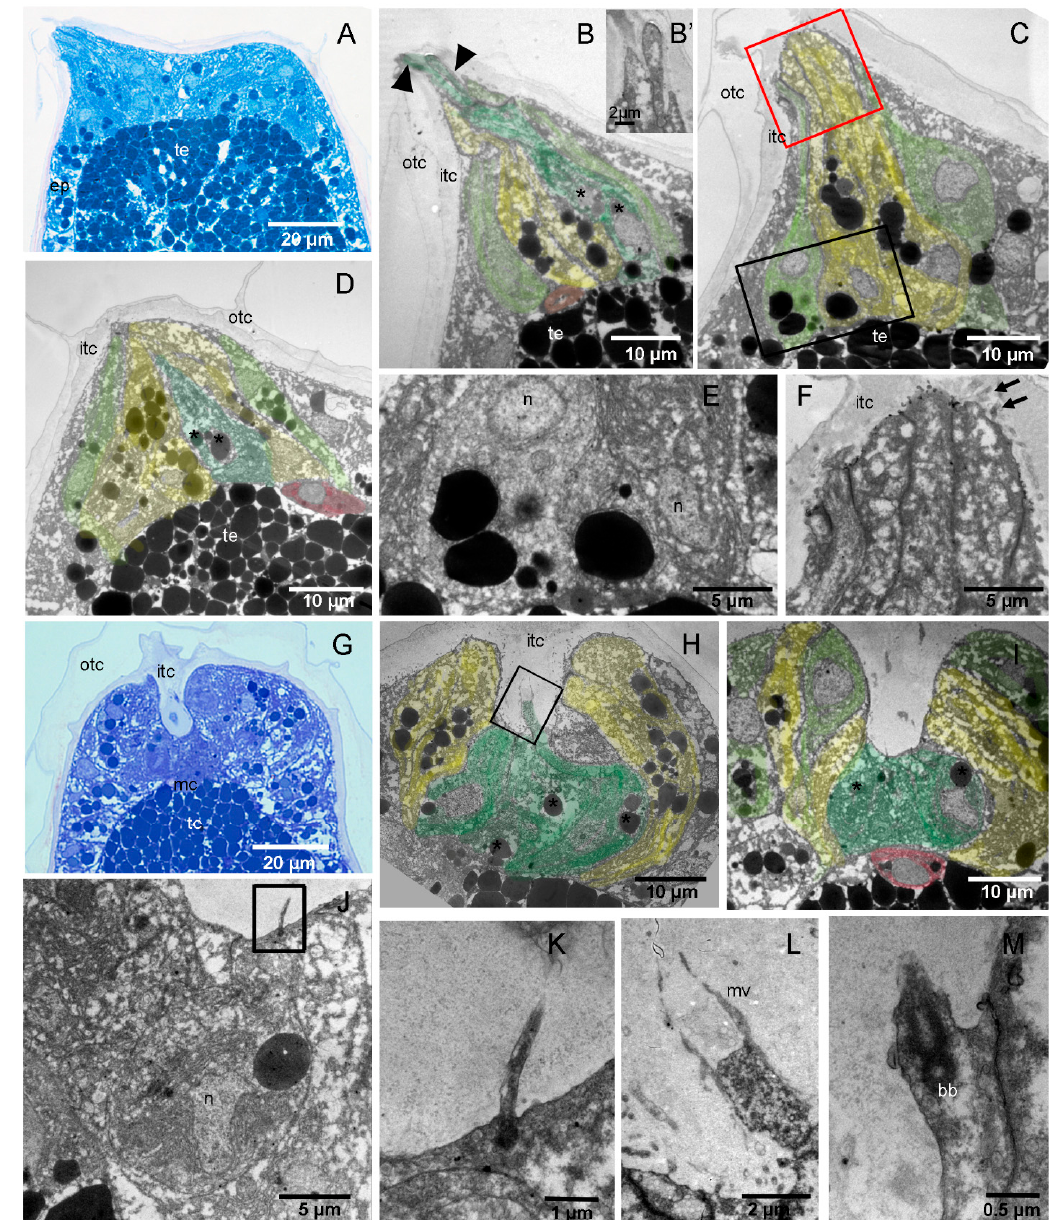
Figure 4. Histological and ultrastructural analysis of adhesive papillae in H. roretzi . ( A – F ) Swim- ming larva: the papillae are conic. ( G – M ) Adhering larva: the papillae have a central groove. ( A , G ) Longitudinal sections of the anterior trunk. Toluidine blue. ( B – F , H – M ) TEM images at differ- ent magnifications and different levels of papillae. Colour code: dark green, ACCs; light green, PSNs; red, mesenchyme cells; yellow, CCs. ( B – D ): Three longitudinal sections of the same papilla. Note that, in ( B ), the finger-like protrusions (arrowheads) of ACCs are also visible in ( B’ ). The black square area in ( C ) is enlarged in ( E ) to show a detail of a PNS basal cytoplasm. The red square area in ( C ) is enlarged in ( F ) to show a detail of CCS distal endings with microvilli. Asterisks: vesicles in ACC. ( H – I ): Two longitudinal sections of the same papilla. The square area in ( H ) is enlarged in ( L ) to show ACC apical endings with microvilli, whereas the square area in ( J ) is enlarged in ( K ) to show a cilium of PSN. ( M ): Cilium basal body belonging to a PSN. bb: basal body of a cilium; mc: mesenchymal cell; mv: microvillus; n: nucleus. See also Figure 1 for